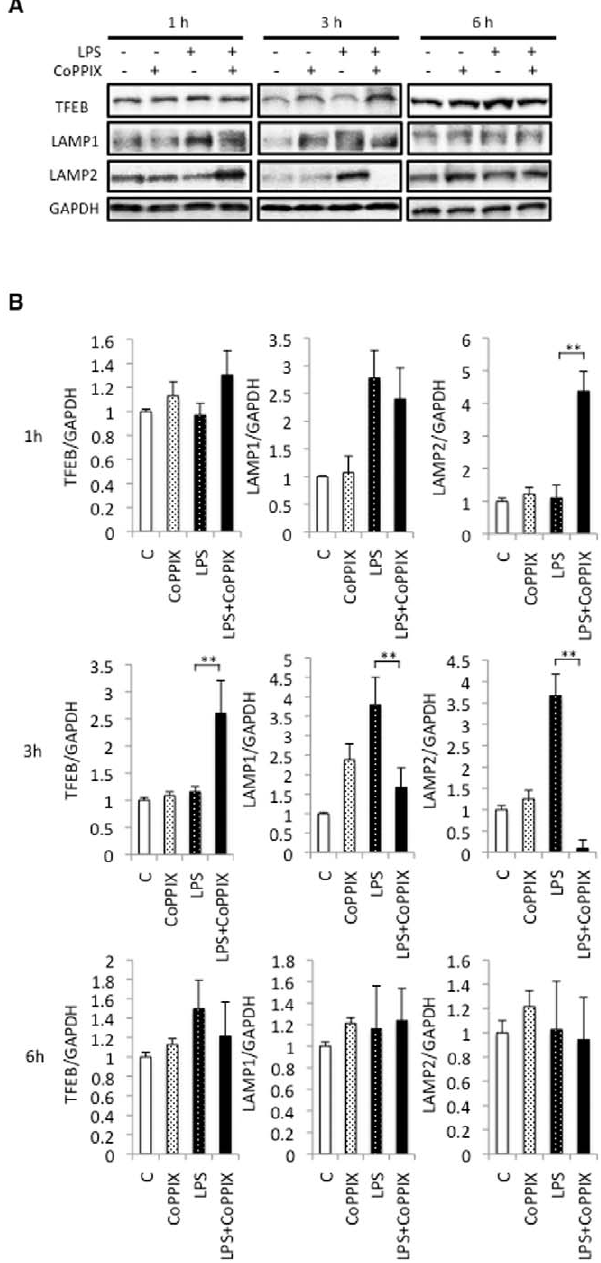
Figure 5. Effects of CoPPIX on lysosome reformation during LPS treatment in the rat heart. A, Western blot analysis of the rat heart treated with LPS (15 mg/kg for 1, 3, and 6 h) with or without CoPPIX pretreatment (5 mg/kg, 24 h) to determine the levels of TFEB, LAMP1, and LAMP2. GAPDH was detected as a loading control. B, Ratios between TFEB, LAMP1, LAMP2, and GAPDH determined using densitometry analysis. Each bar represents the mean 6 S.E. of four animals (**p , 0.01). Times indicated at the leftmost side in the panel show the treatment times for LPS.